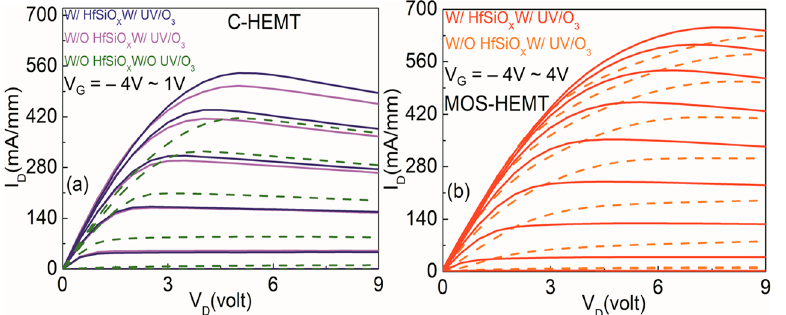
Figure 3. Comparison of drain current-voltage (I D -V D ) characteristics of ( a ) conventional HEMT (C-HEMT) (before and after UV/O 3 treatment) and ( b ) MOS-HEMT with and without HfSiO X pas- sivation.